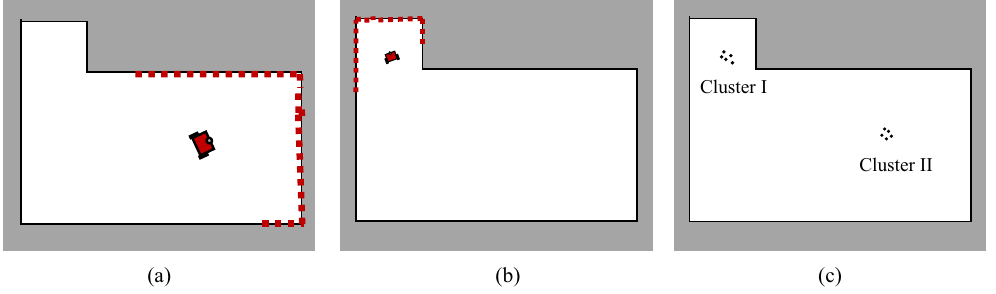
Figure 4. An example scenario where particle collapse may happen: ( a , b ) depict two different robot states which are about equally possible according to the sensor model. ( c ) shows two clusters of particles generated at the same moment, around the hypothesis